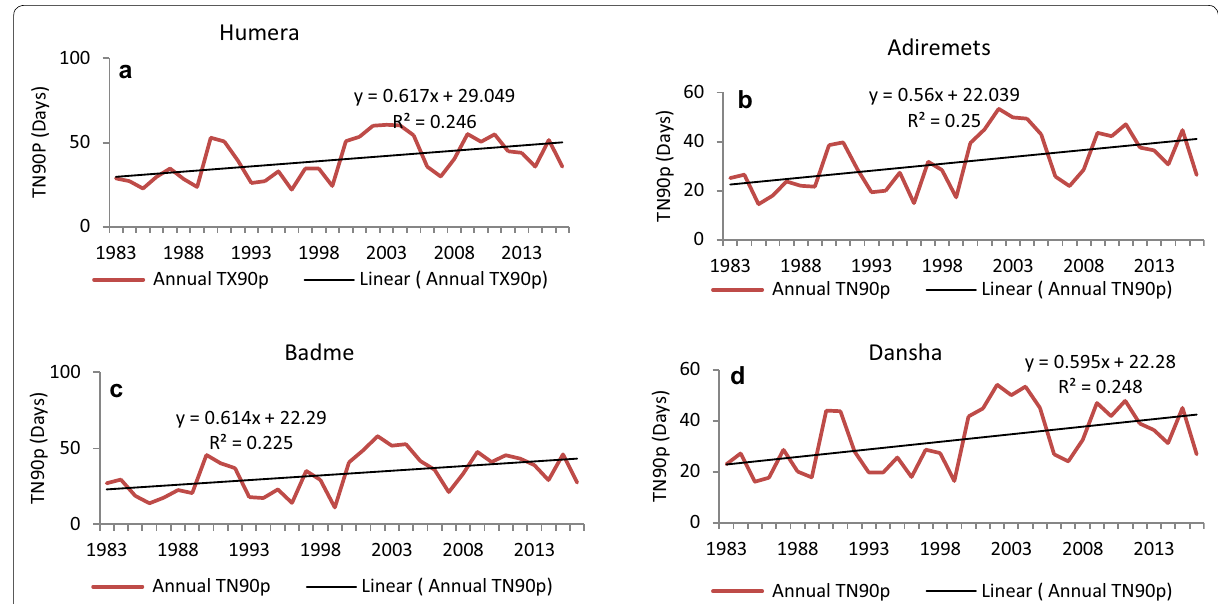
Fig. 8 Average annual warm nights (TN90p) at a Humera, b Adiremets, c Badme and d Dansha